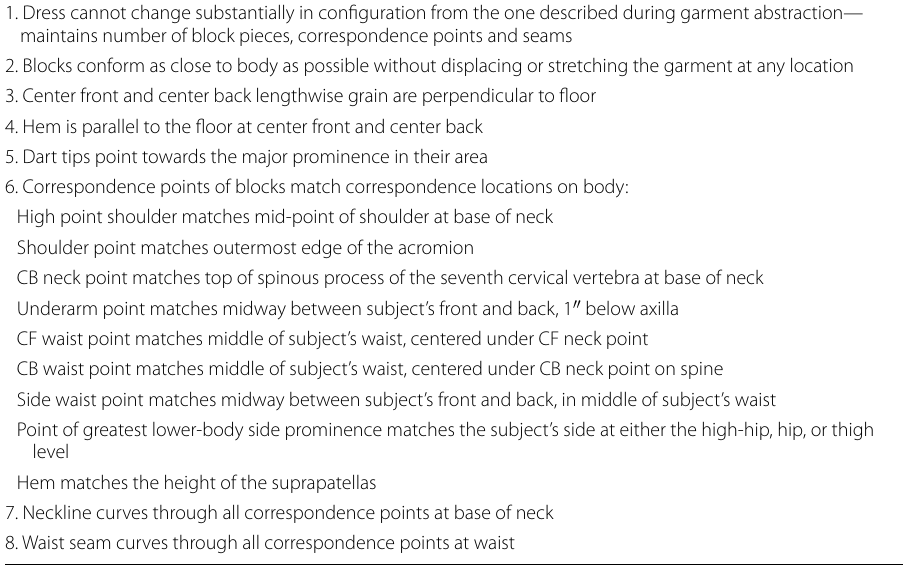
Table 2 Fitting rules for sheath dress, developed directly from analysis of